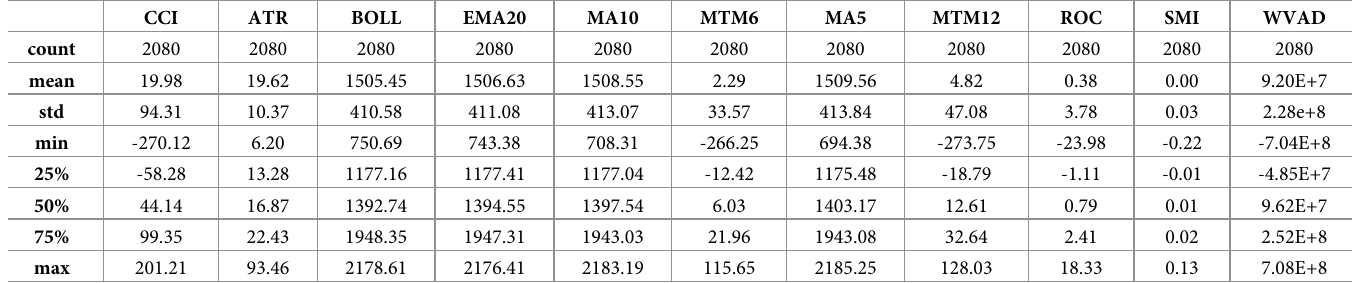
Table 2. Summary statistics of selected input variables (technical indicators) (S&P500). CCI ATR